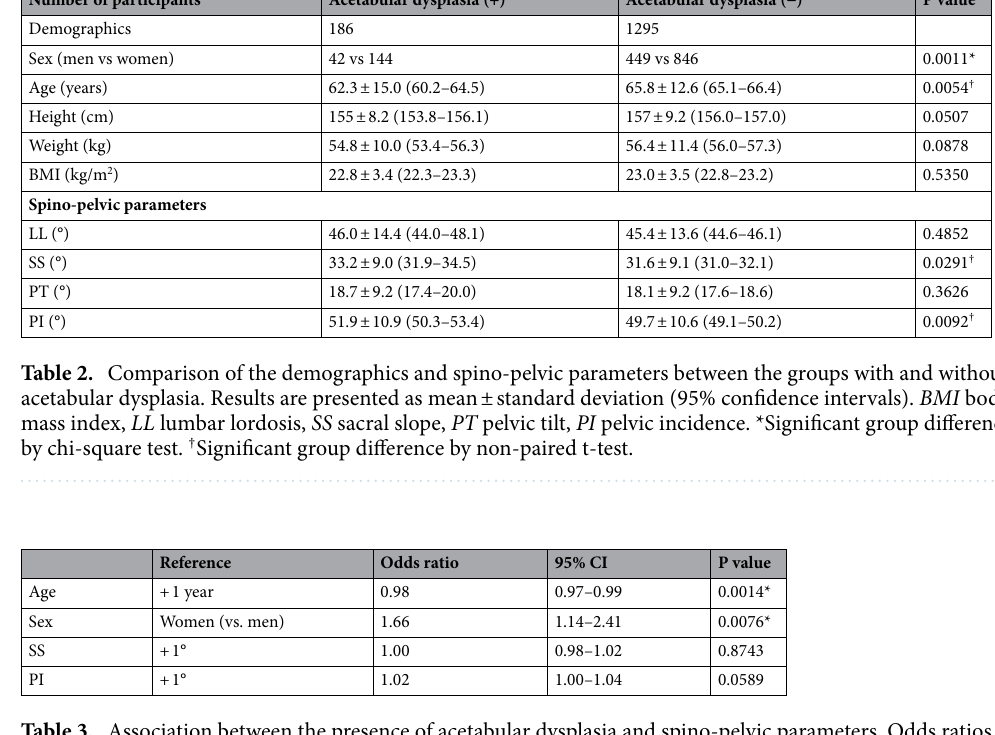
Table 3. Association between the presence of acetabular dysplasia and spino-pelvic parameters. Odds ratios are calculated by multiple logistic regression analysis on 1481 participants. 95% CI 95% confidence interval, SS sacral slope, PI pelvic incidence. *Statistically significant association with acetabular